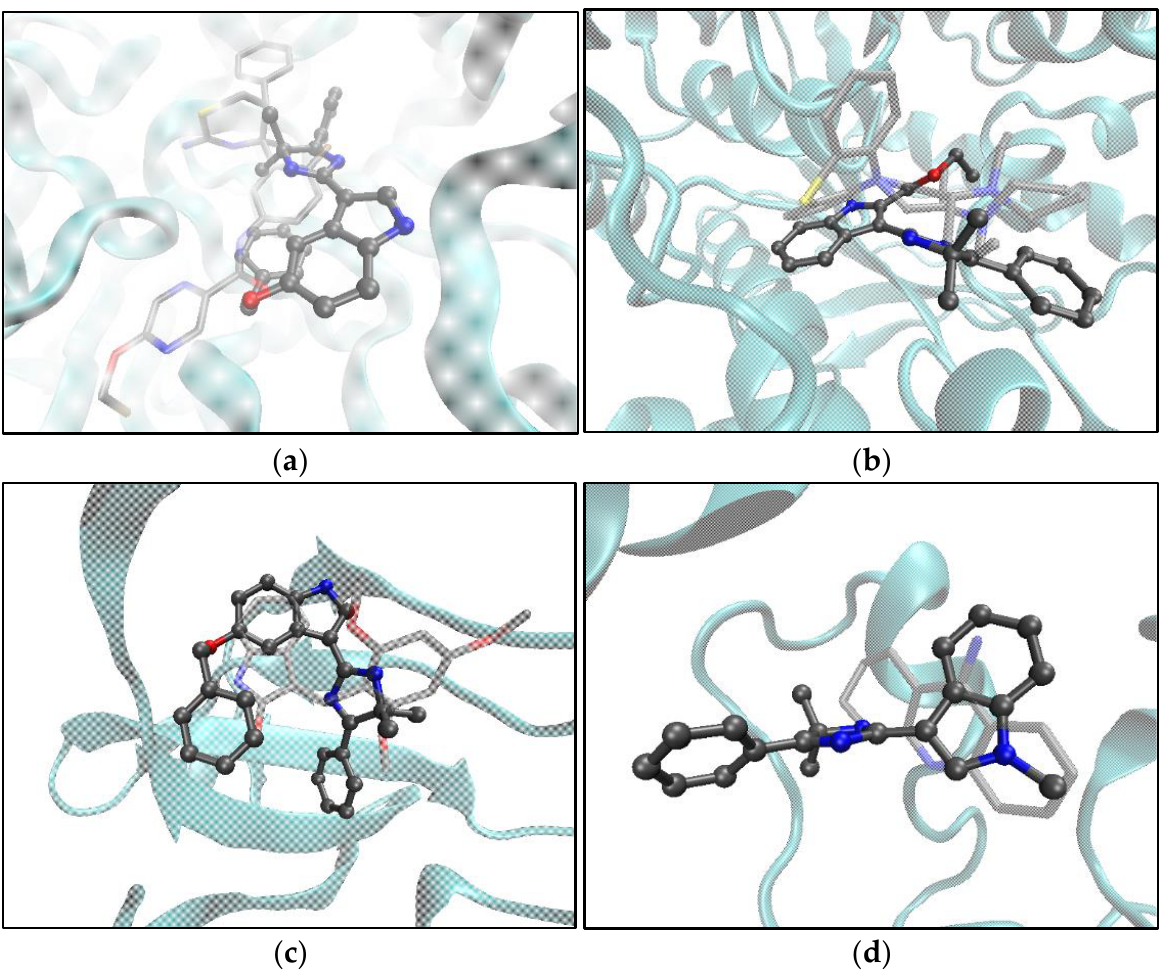
Figure 4. Leading compounds (opaque with bonds as cylinders and atoms as spheres) compared with native ligands (transparent with bonds as cylinders) in the corresponding targets (transparent, cyan): ( a ) 5b in BACE1; ( b ) 5d in BChE; ( c ) 5b in CK1 δ ; ( d ) 5a in AChE. – Atom colors are presented according to CPK ( Corey–Pauling–Koltun) color scheme.